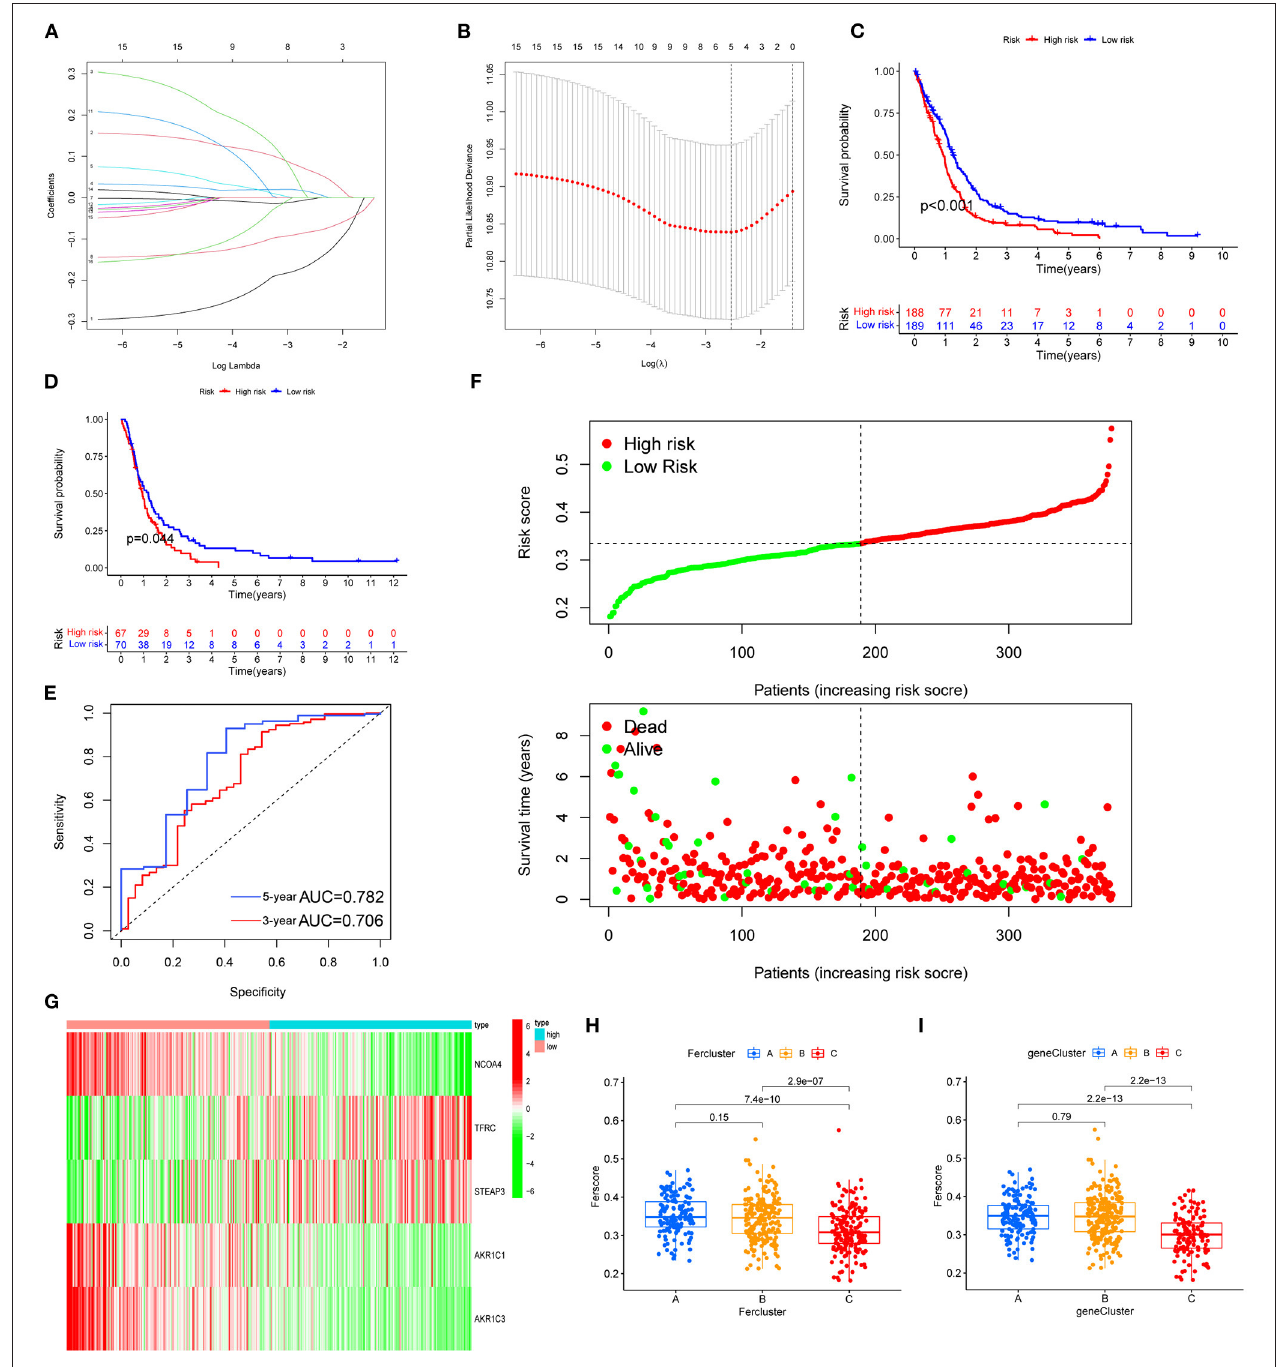
FIGURE 7 | FRG prognostic signature. (A,B) The process of building the signature. LASSO regression was performed, calculating the minimum criteria. (C,D) Kaplan–Meier curves showed that the high-risk subgroup had worse OS than the subgroup in training set ( C , p < 0.001) and test set ( D , p < 0.001). (E) ROC curves showed the predictive efficiency of the risk signature on the 3-year and 5-year survival rates of training set (3-year AUC = 0.706, 5-year AUC = 0.782). (F) The distributions of risk scores and the distributions of risk scores and OS status. The green and red dots indicated the alive and dead status, respectively. (G) The heatmap based on the expression of the five genes in the high- and low-risk group. (H,I) According to the formula, the different clustered samples are scored using the coefficients.